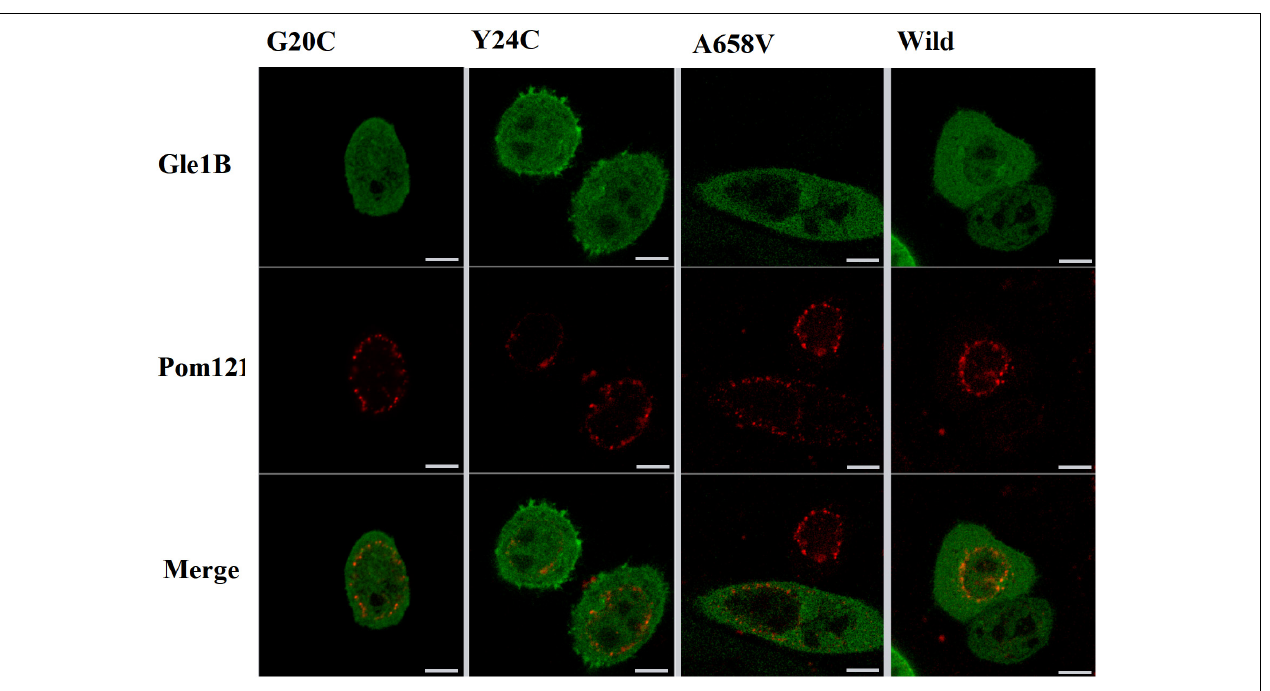
mutation (c.1965-2A > C, hGle1-IVS14-2A > C) identified by Kaneb et al. (2015) resulted in the replacement of 44 amino acids at the carboxyl terminus of the hGle1B isoform. This